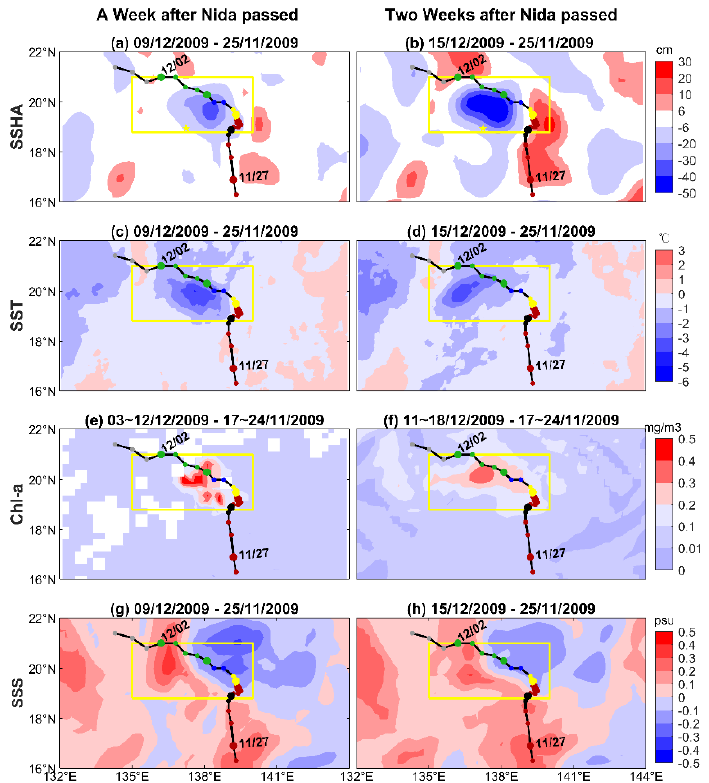
Figure 6. The sudden-turning stage. ( a , b ) The SSHA fields (shaded, cm) on 9 and 15 December 2009, indicating one week and two weeks after the passage of Nida, respectively. ( c , d ) The SST responses (shaded, cm) on 9 and 15 December 2009. ( e , f ) The chl- a and zooplankton responses (shaded, cm) several weeks after the passage of typhoon Nida. ( g , h ) The SSS responses (shaded, cm) on 9 and 15 December 2009. The yellow rectangle and yellow star indicate the cold eddy area and the location of Argo float 2900401, respectively.